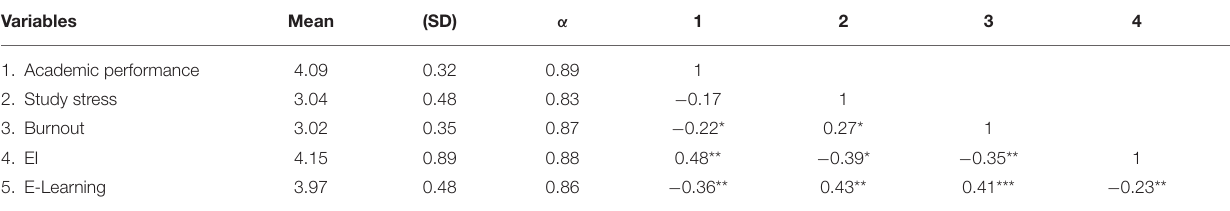
TABLE 2 | Correlations analysis. Variables